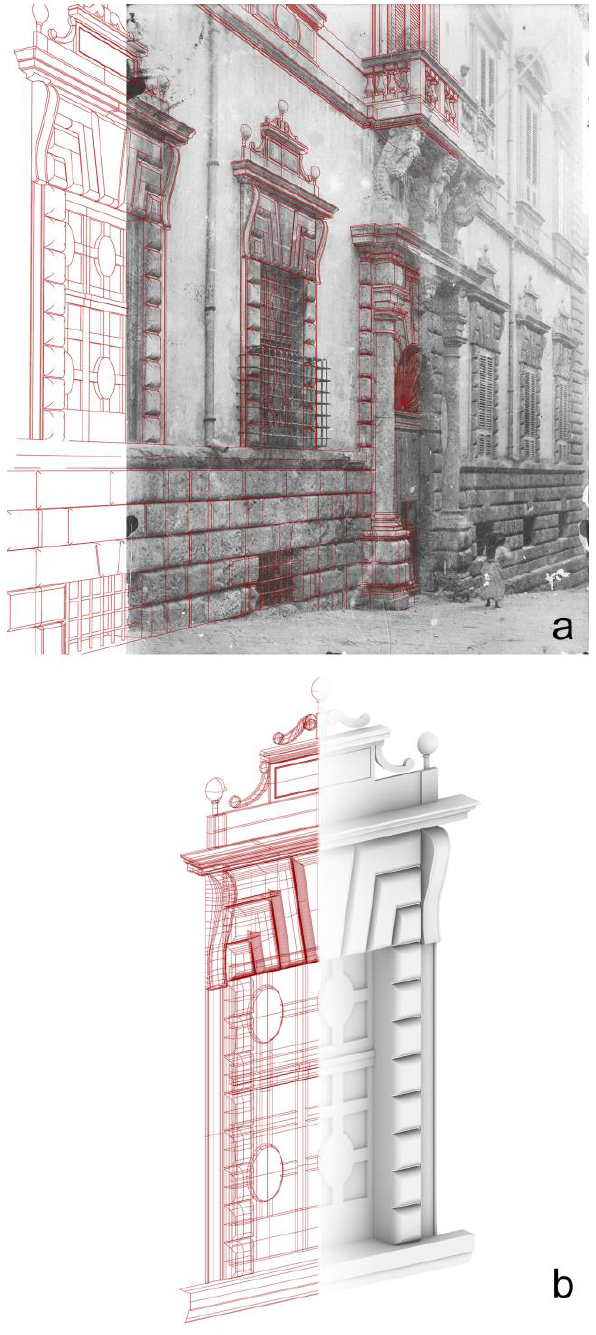
Figure 12 . Reconstruction of the first level of the façade.